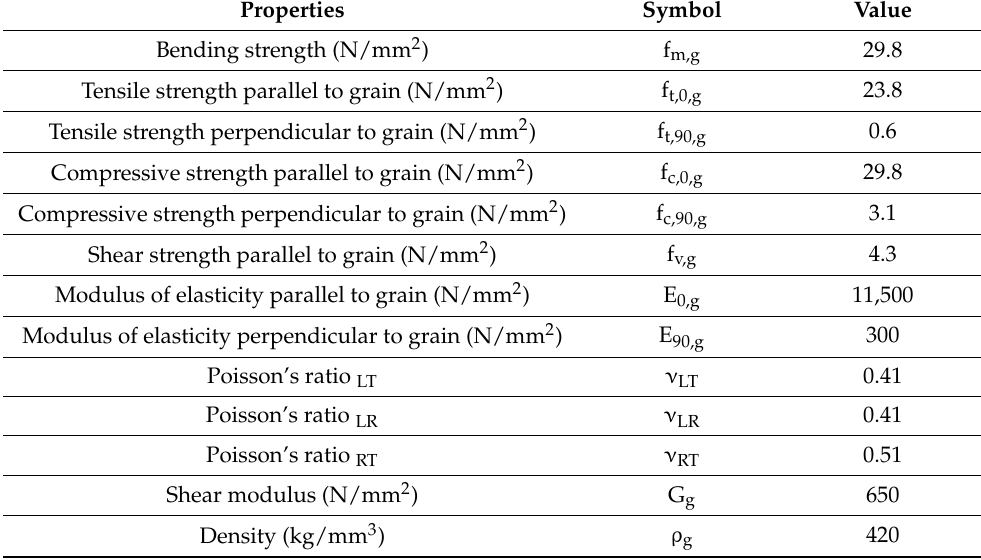
Figure 4. Example of the internal area of timber. Appearance of polished wood ( P. abies ) used in this work: ( top and bottom ) several details (indicated by red squares and magnified above and below) of the wood and ( central ) wood cut by the plane of symmetry of Figure 3, mid-configuration section. Table 1. Mean properties of the timber used, of strength class GL24h ( P. abies